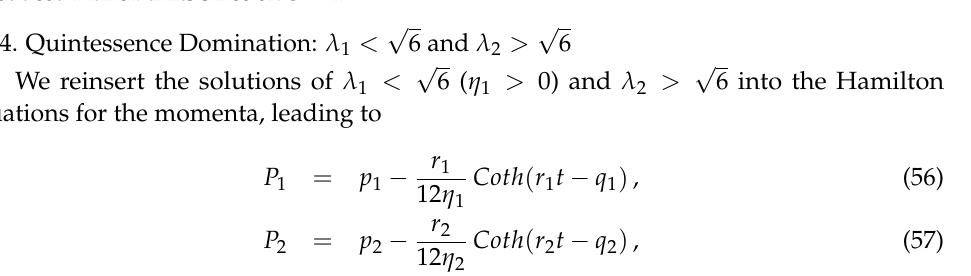
Figure 2. Phantom domination. This figure shows the time (0.1 ≤ t ≤ 2.5) evolution of the scale factor A ( t ) , the Hubble parameter H ( t ) , and the barotropic parameter ω φ units, namely, V 1 = V 2 = 1.0, r 1 = 1.5, r 2 = 0.9, q 1 = q 2 = 0.1, a 3 = − 6.0, λ 2 = The remaining constants can be obtained from the aforementioned values. Note that time is measured in reduced Planck units since 8 π G =